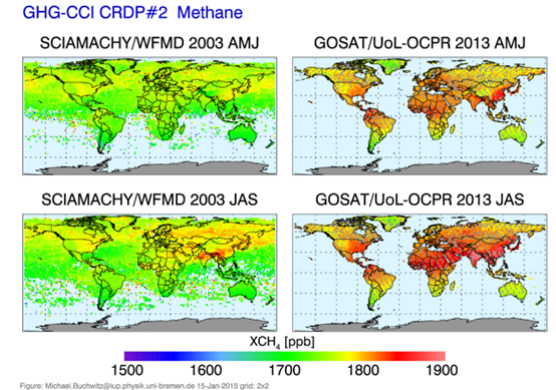
Fig.3: GHG-CCI CRDP#2 XCH 4